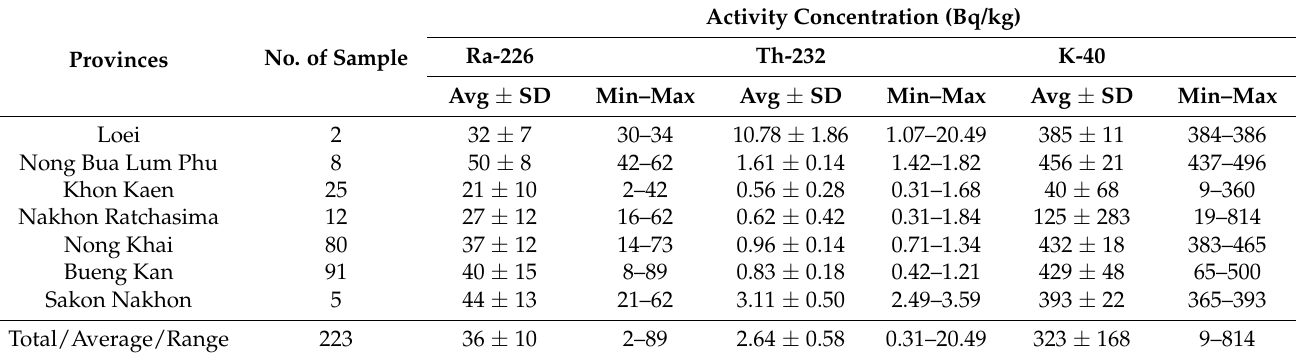
The average results of the activity concentrations of Ra-226, Th-232, and K-40 ( C ) are shown in Table 2 and the indoor external dose rates ( D in ), the annual indoor effective dose ( E in ), the activity concentration index ( I ) the radium equivalent activity ( Ra eq ), the external hazard index ( H ex ), the internal haphazard index ( H in ), and the excess lifetime cancer risk ( ELCR ) are shown in Table 3. The average results of this study were compared with reports of Ra-226, Th-232, and K-40 concentrations and D in , E in , I , Ra eq , H ex and H in values from sand samples in the different countries, the world averages, and the guideline levels (Table 4). Table 2. The average activity concentration (Bq/kg) from sand samples collected from Loei, Nong Bua Lam Phu, Khon Kaen, Nakhon Ratchasima, Nong Khai, Bueng Kan, and Sakon Nakhon provinces in Northeastern Thailand.